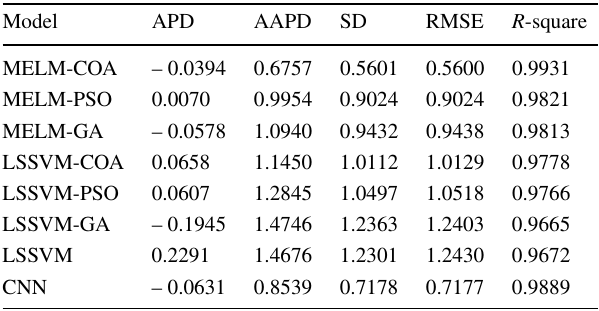
Table 6 Analyzing the results of different models for predicting the permeability from the training data using different error indices and R 2